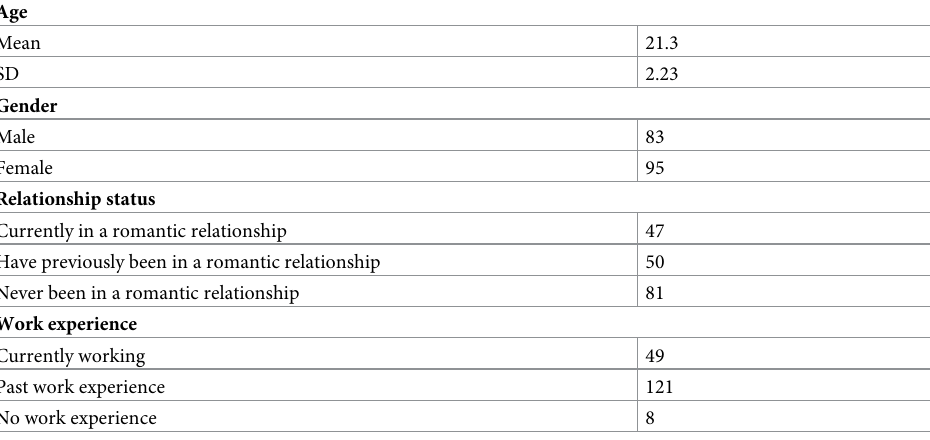
Table 1. Descriptive statistics for age, gender, relationship status, and past work